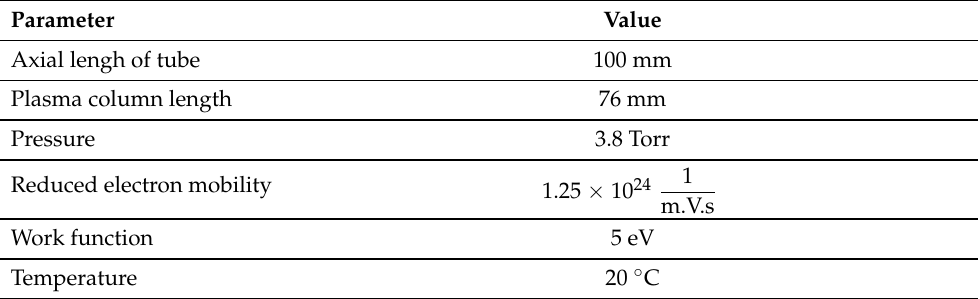
Table 1. Simulation parameters for plasma column.